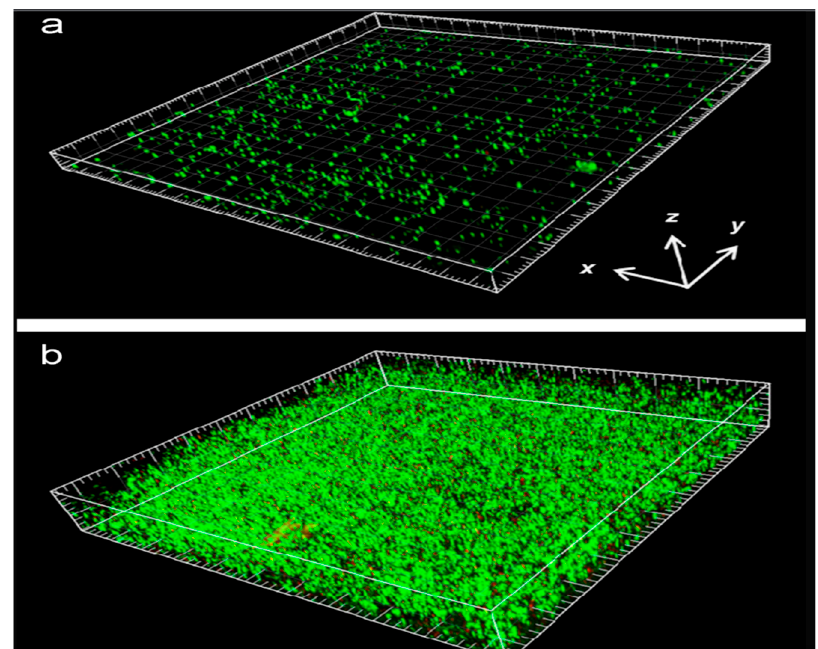
Figure 3. Confocal laser scanning microscopy (CLSM) images after biofouling occurrence: ( a ) VA- CNT membrane vs. ( b ) UF membrane (green: live cells) (Reproduced with permission from Elsevier; adapted from Baek et al, 2014 [44]).